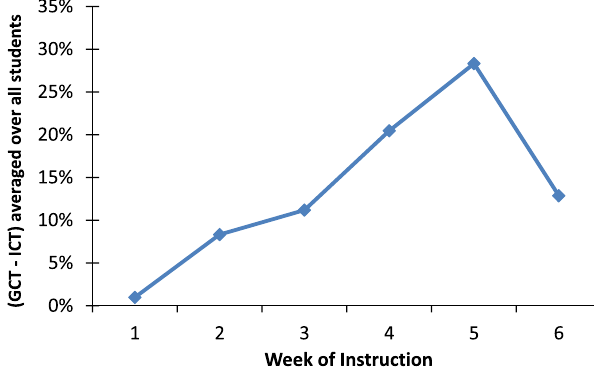
FIG. 10. (GCT — ICT) for each week of instruction (averaged over all students and all questions for that week). The average standard error was (cid:2) 8 .